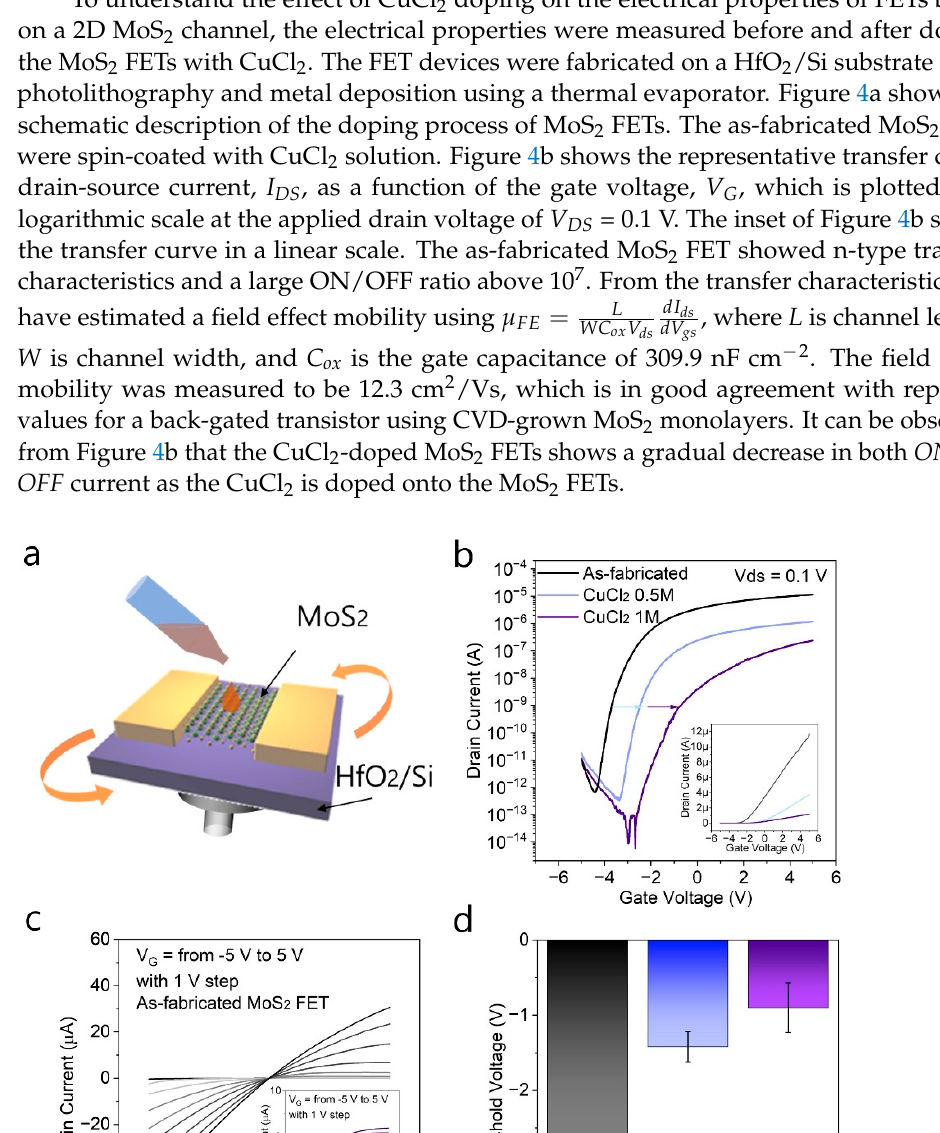
Ohmic contact between MoS 2 and electrodes. As the CuCl 2 is doped onto MoS 2 FETs, the channel conductance is largely decreased, showing a p-type doping effect of CuCl 2 on MoS 2 , in accordance with transfer curve measured in Figure 4b. Following the reduced ON current and channel conductance, it was also shown that as CuCl 2 was doped onto MoS 2 FETs, threshold voltage ( V th ) was shifted towards positive voltages from -2.85 V to -1.45 V and -0.9 V as 0.5 M and 1 M CuCl 2 was doped onto MoS 2 FETs as shown in Figure 4d. Using the changes in the V th , the change in carrier concentra- tions upon CuCl 2 doping can be calculated using the parallel-plate capacitor model [3,9], 𝑁 (cid:3031)(cid:3042)(cid:3043)(cid:3036)(cid:3041)(cid:3034) = (cid:3004)|∆(cid:3023)(cid:3047)(cid:3035)| (cid:3032) , where C is the gate capacitance, ∆𝑉 (cid:3047)(cid:3035) is the change in the V Th after the CuCl 2 is doped onto the device compared to the as-fabricated MoS 2 FET, and 𝑒 is the el- ementary charge. The amount of doping concentration was estimated to be 2.72 × 10 (cid:2869)(cid:2870) cm − 2 and 3.77 × 10 (cid:2869)(cid:2870) cm − 2 when 0.5 M CuCl 2 and 1 M CuCl 2 were doped onto MoS 2 FETs,